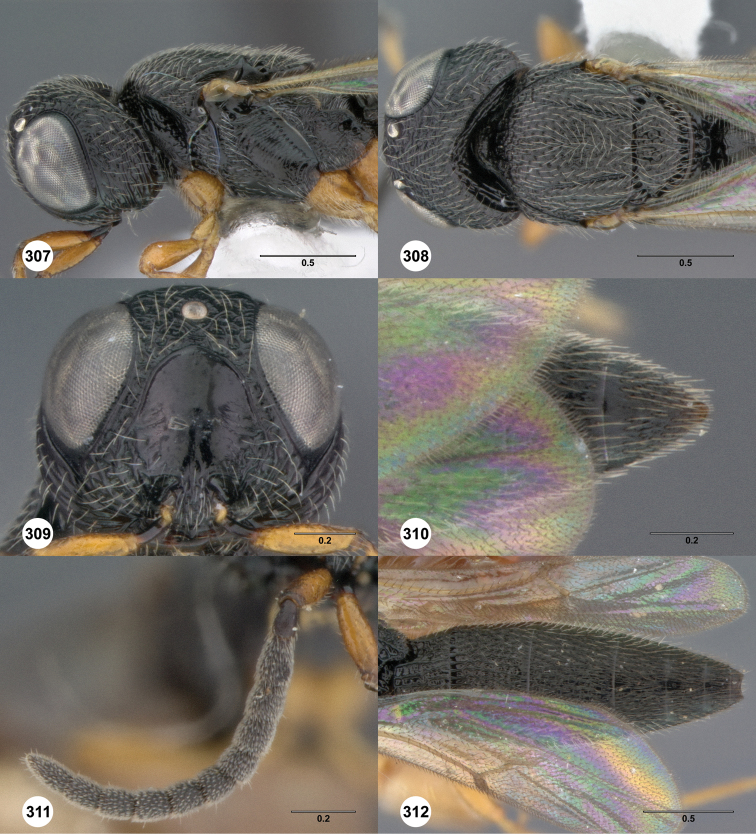
Oxyscelio sciuri sp. n., paratype female (OSUC 462577) 307 Head and mesosoma, lateral view 308 Head and mesosoma, dorsal view. Paratype female (OSUC 462576) 309 Head, anterior view 310 Metasoma, dorsal view. Paratype male (OSUC 368208) 311 Antenna 312 Metasoma, dorsal view. Morphbank86